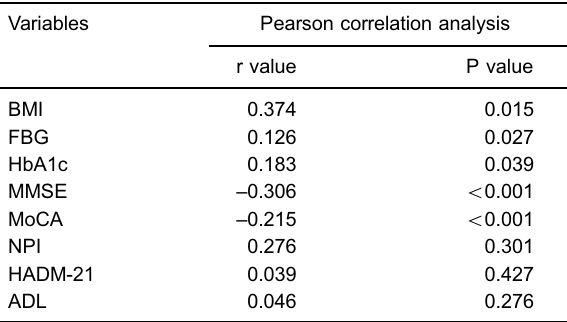
BMI: body mass index; FBG: fasting blood glucose; HbA1c: glycated hemoglobin; MMSE: Mini-Mental State Examination; MoCA: Montreal Cognitive Assessment scale; NPI: Neuropsy- chiatric Inventory; HADM-21: Hamilton depression rating scale 21-item; ADL: Activities of Daily Living